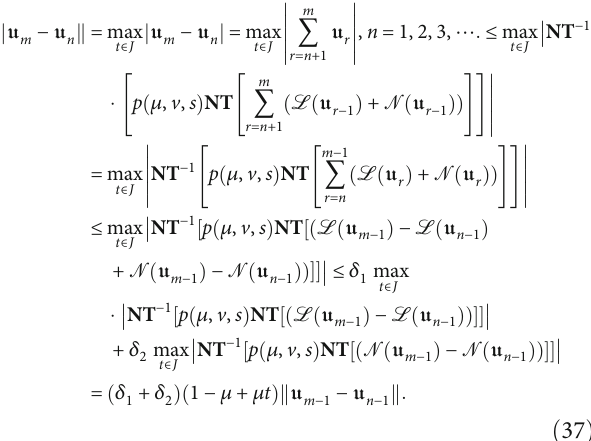
FNDM [28] q − HATM [28]